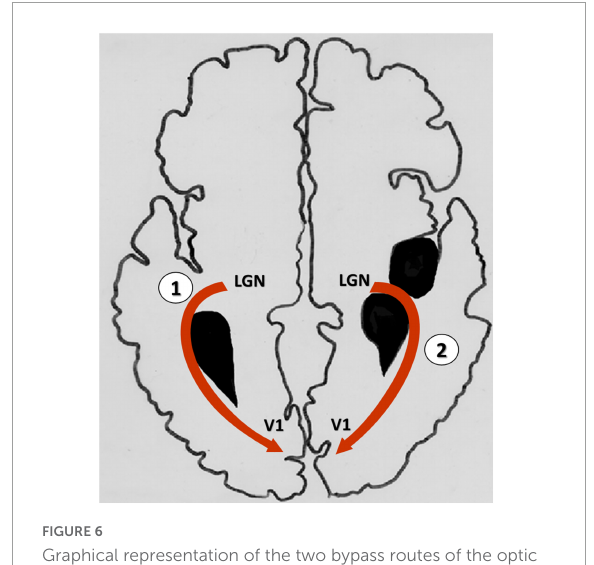
FIGURE6 Graphical representation of the two bypass routes of the optic radiations in the lesional hemisphere. (1) Optic radiations contouring the edge of lesion to reach the primary visual cortex; (2) Optic radiations passing through the lesion attain the visual cortex. LGN, Lateral geniculate nucleus; V1, primary visual